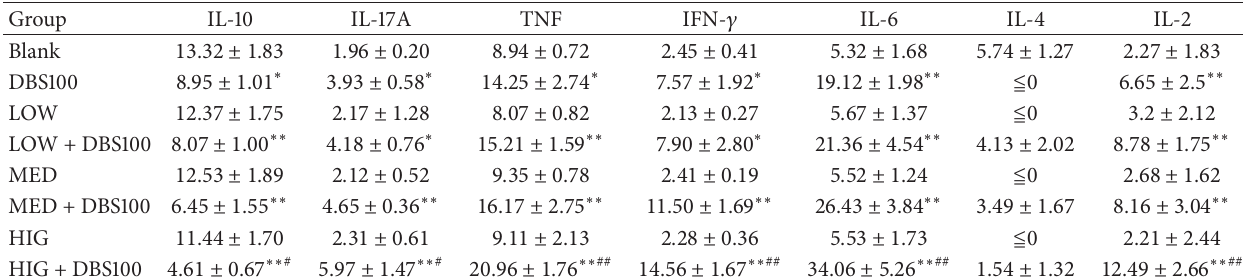
Table 4: Expression levels of the inflammatory cytokines (pg/ml, mean ±